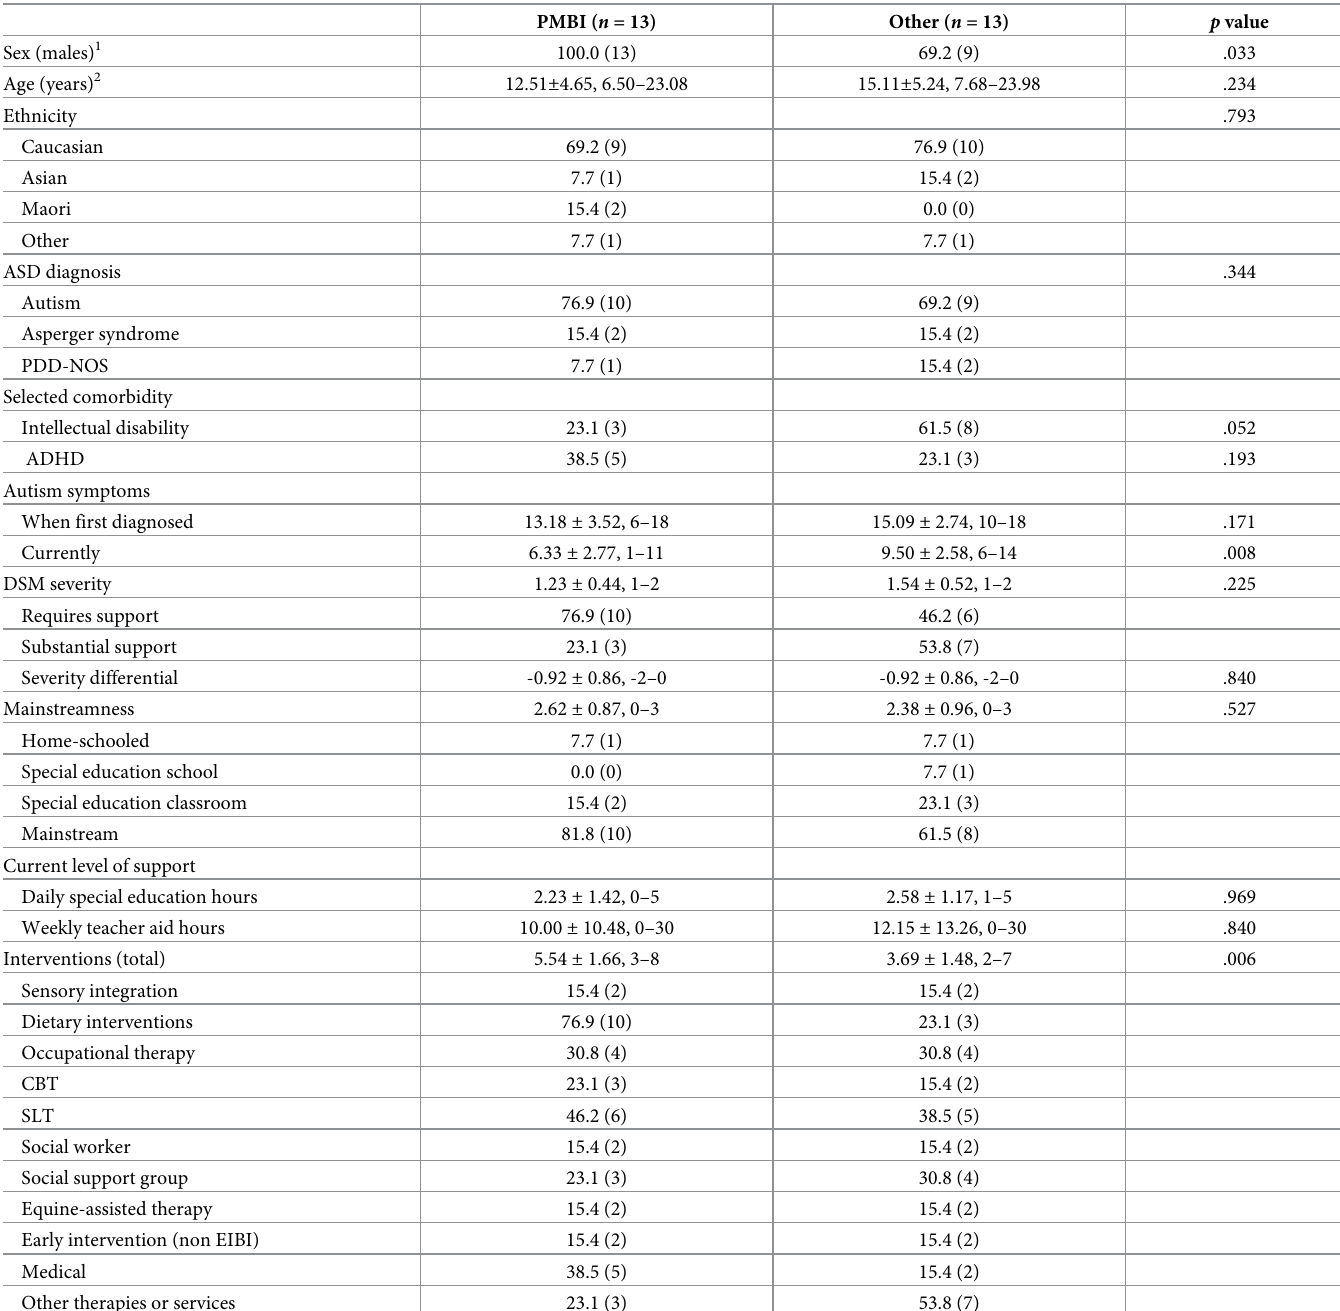
Table 1. Participant